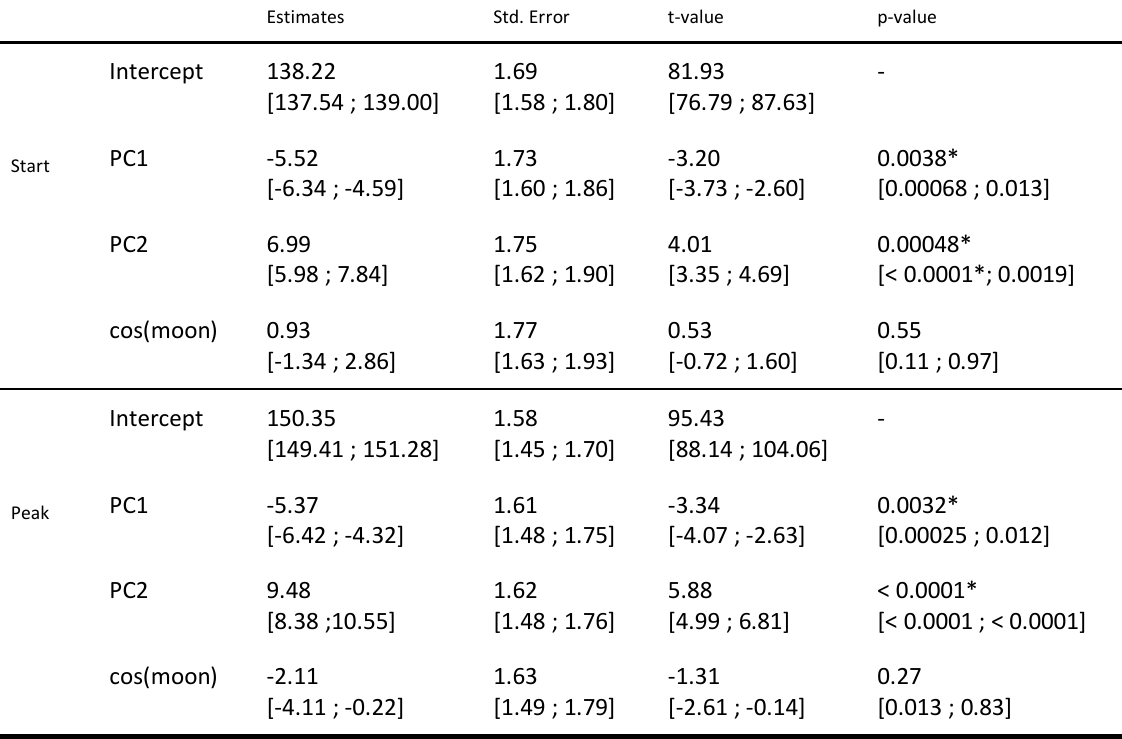
Table S2. Summary of the simulated linear regressions on the start and peak of the breeding season. For each variable we show the estimate, its standard error, and the t-value and p-value associated with it. In square brackets we show the 2.5 th and the 97.5 th percentile values, obtained by simulating 1000 times the dates and running 1000 models. Asterisks next to the p-value show significance at the 0.05 level. No p-values are provided for the intercept because this test is not of biological